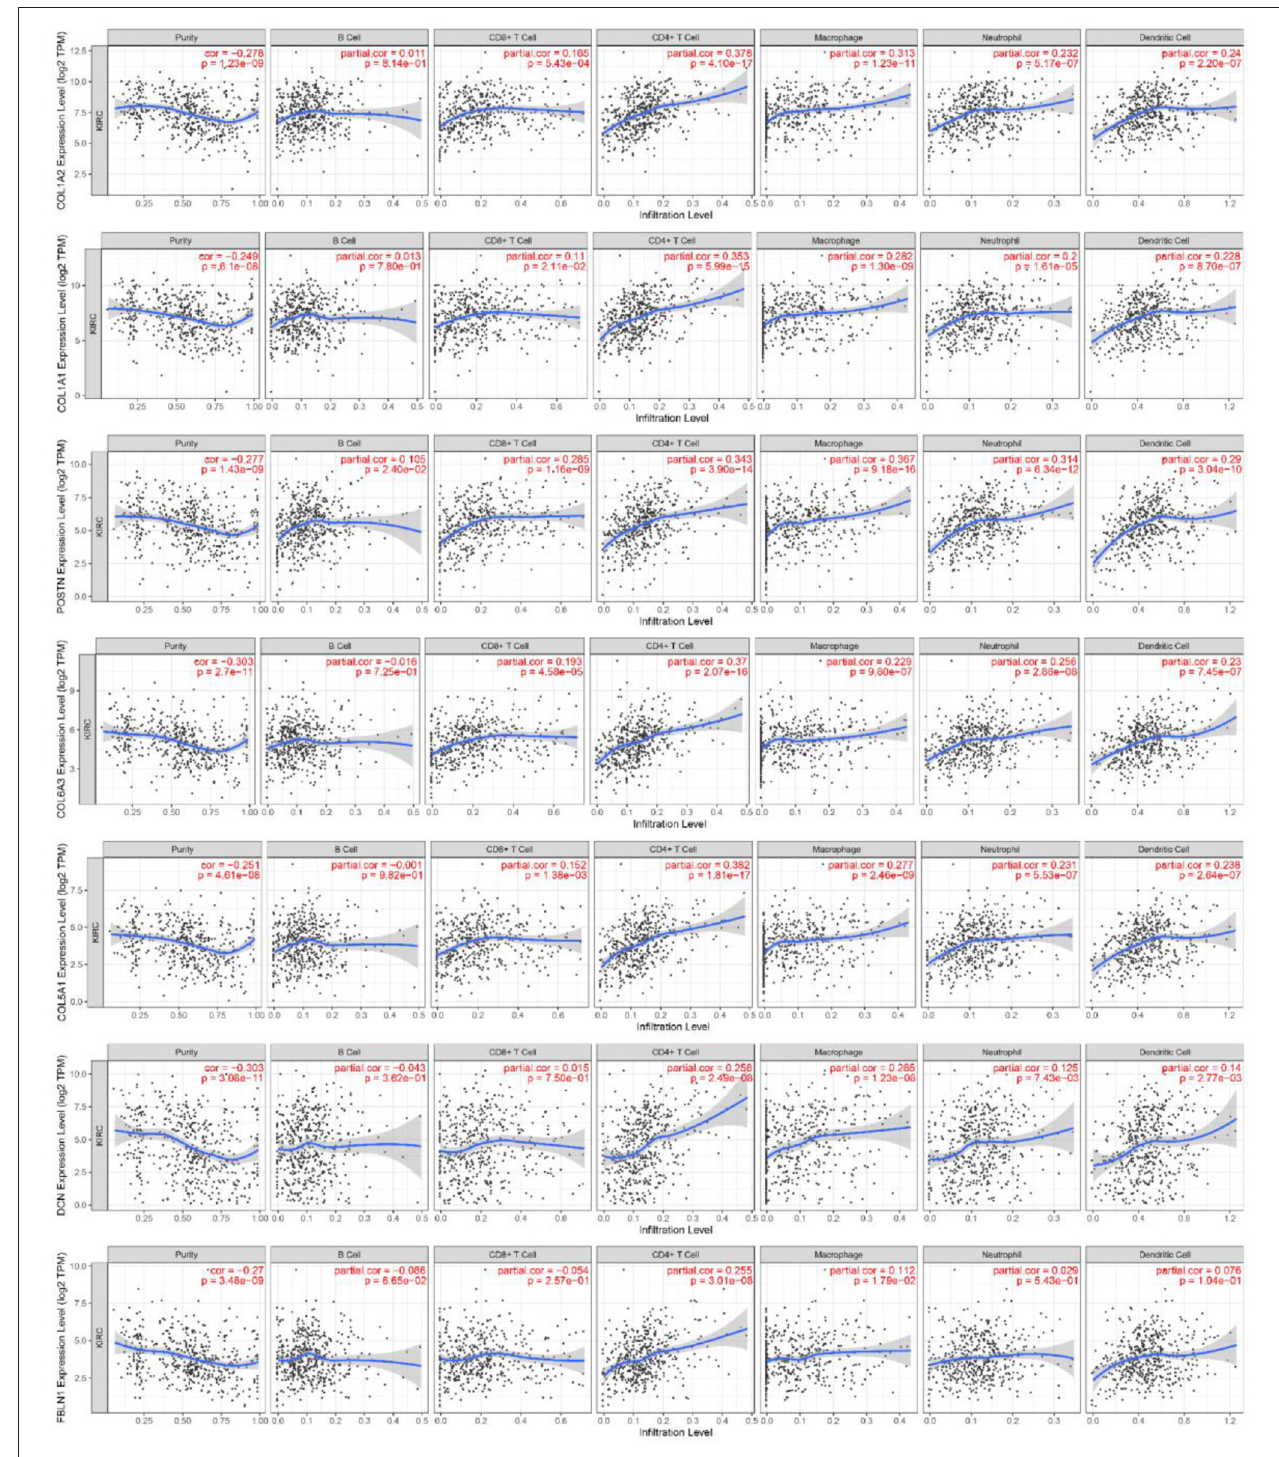
FIGURE 9 | Association of core gene expression in ccRCC with immune infiltrates. Partial correlation analysis of gene expression and tumor immune infiltrate levels (B cells, CD8 + T cells, CD4 + T cells, macrophages, neutrophils, and dendritic cells).